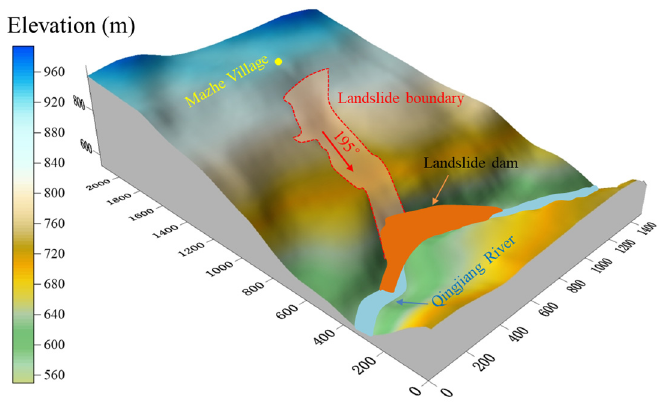
Figure 7. Three-dimensional topography of the landslide.